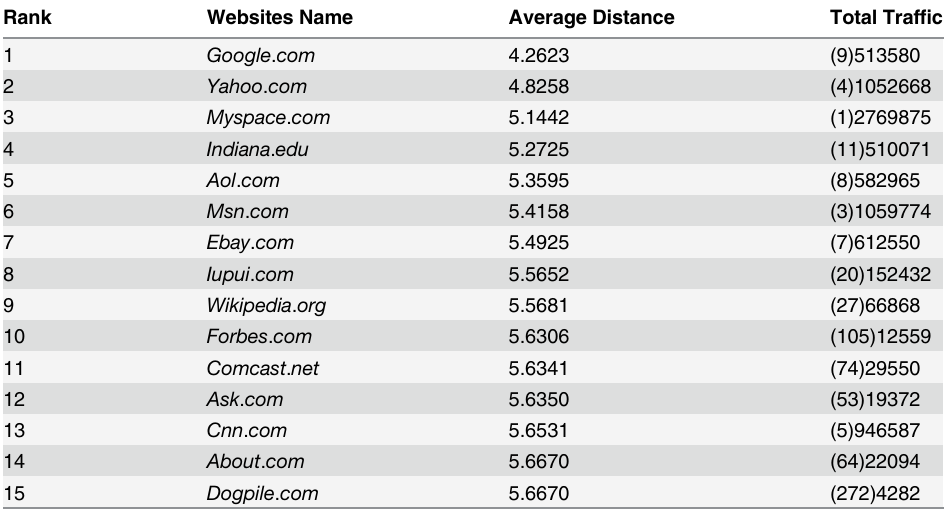
Table 2. Top 15 websites with shortest average